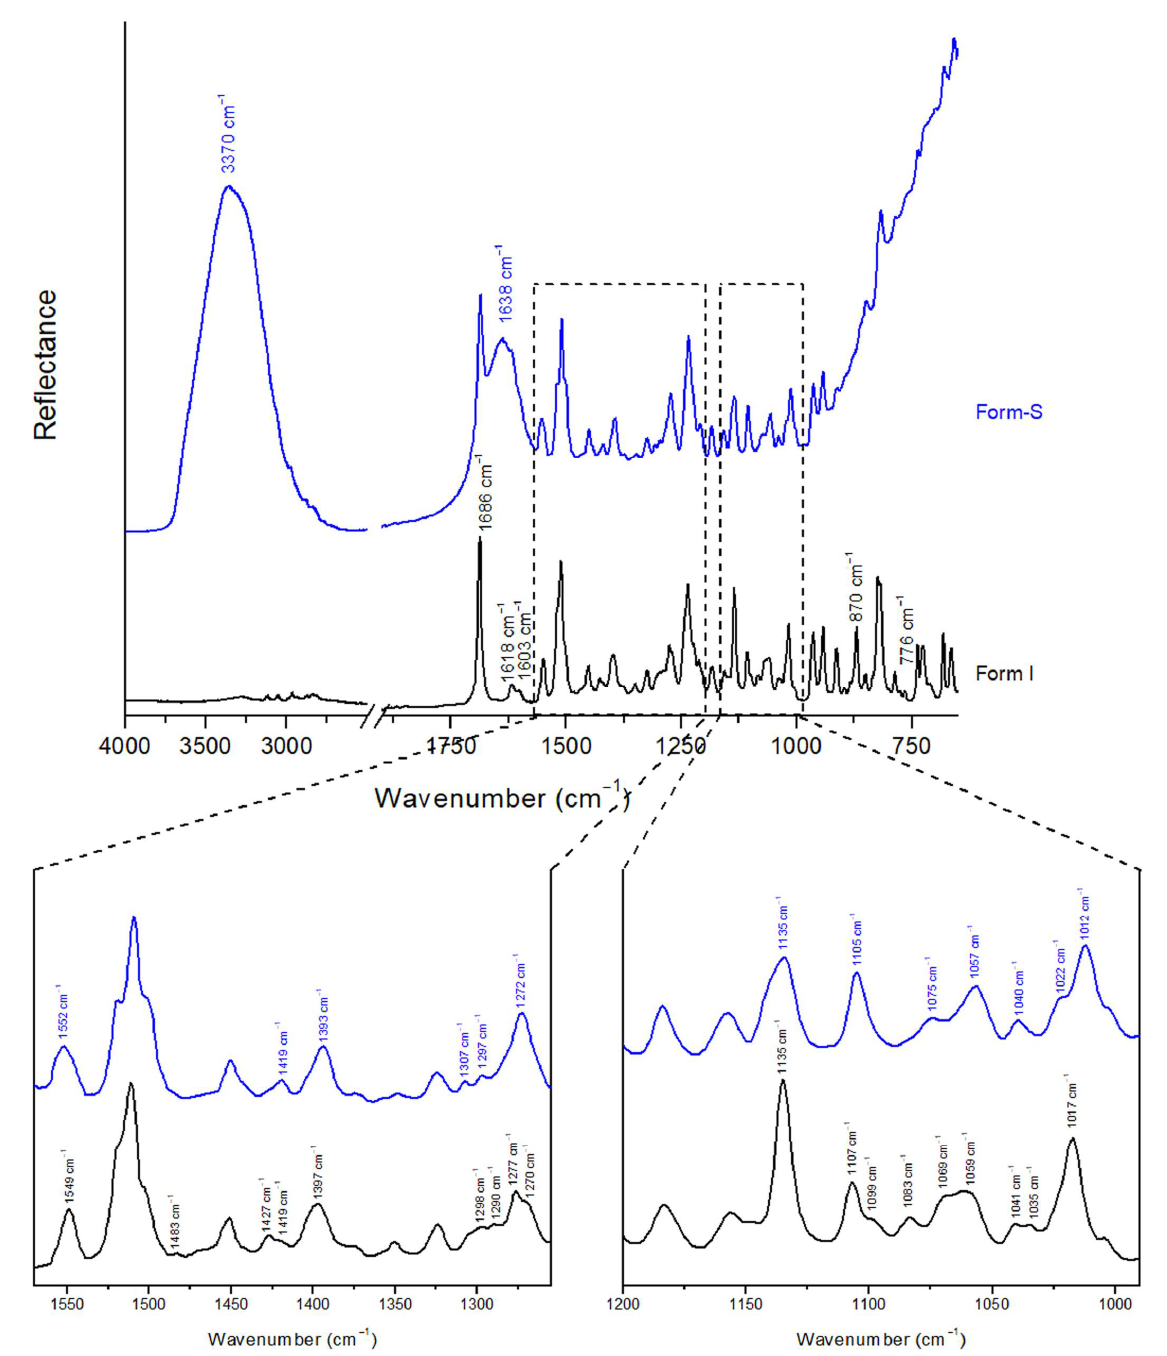
Figure 6. ATR spectra of posaconazole Form I and posaconazole Form-S. Inset: magnification of spectral areas 1570–1255 cm −1 and 1200–990 cm −1 (black peak labels: characteristic peaks for posaconazole Form I; blue peak labels: characteristic peaks for posaconazole Form-S). Various minor peak shifts and some more prominent differences were detected in the ATR spectrum of Form-S compared to that of Form I (Figure 6). The peak at 1012 cm −1 with the shoulder at 1022 cm −1 is characteristic for Form-S, while Form I is characterised by a peak at 1017 cm −1 . Moreover, the presence of the double peak at 1075 cm −1 and 1057 cm −1 is representative for posaconazole Form-S, whereas in the ATR spectrum of Form I, a broad peak from 1069 cm −1 to 1059 cm −1 was observed (Table 5).